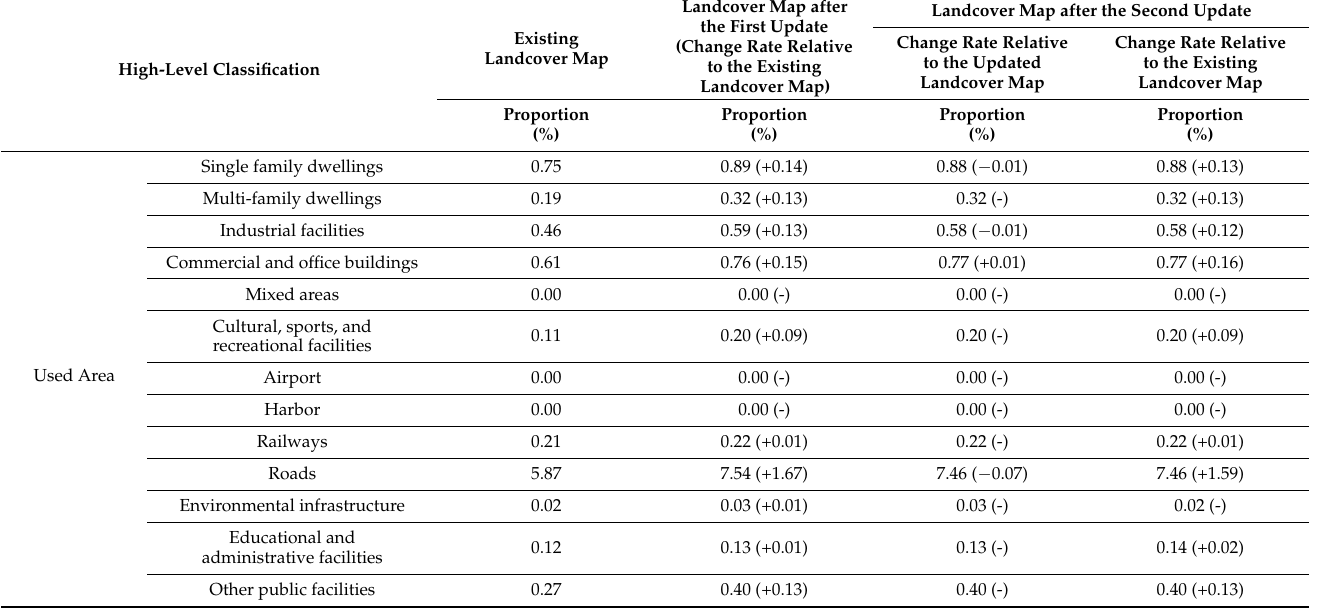
Table 3. Comparison of change rates after the first and second update